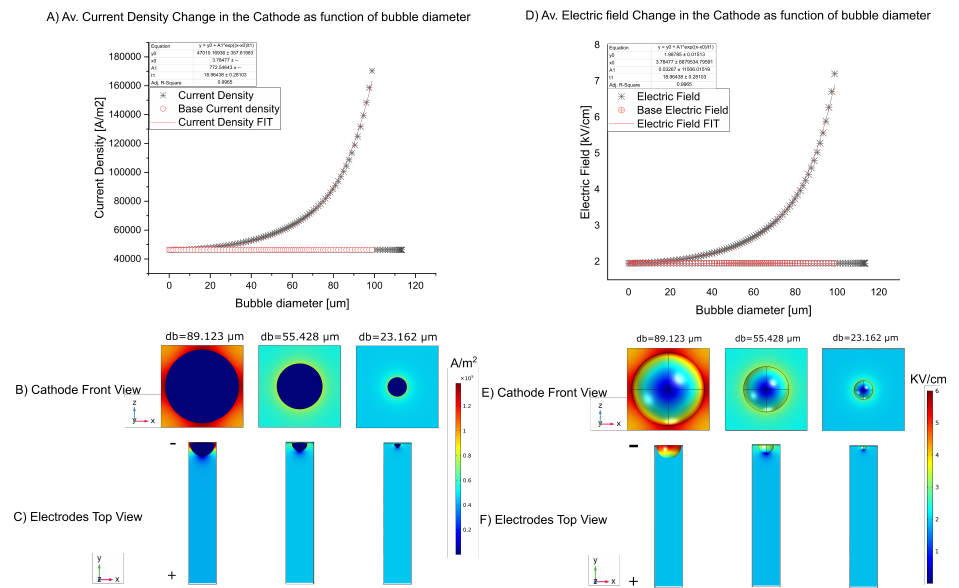
Figure 8. ( A ) Average Current density changes as function of bubble diameter for 100 V Assay at 0°. ( B ) Current density change as function of the bubble diameter in the cathode surface. ( C ) Current density distribution between the electrodes. ( D ) Electric field changes as function of bubble diameter for 100 V Assay 0°. ( E ) Electric field change as function of the bubble diameter in the cathode surface. ( F ) Electric field distribution between the electrodes.